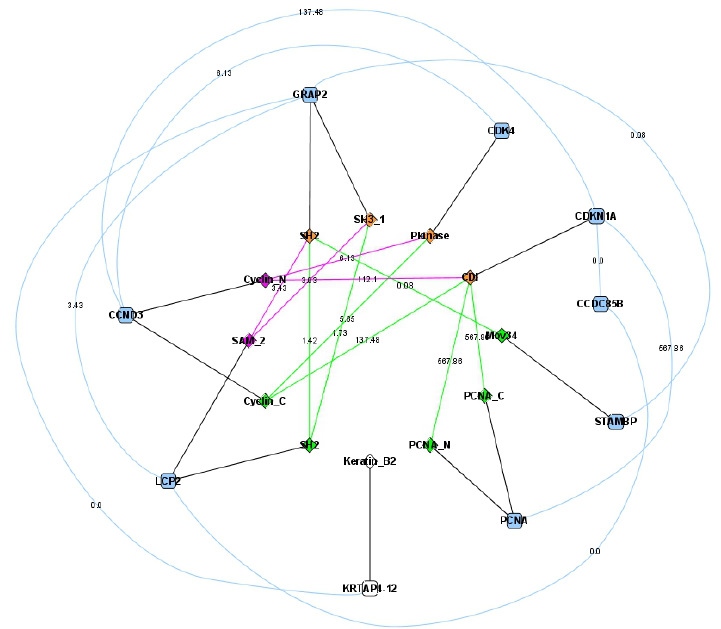
Figure 2: Sample domain graph from Figure 1 with integrated exon expression data. Pink domain nodes indicate the loss of the domain due to alternative splicing events. Orange nodes represent indirectly a ff ected domains. White nodes have no A ff ymetrix probesets